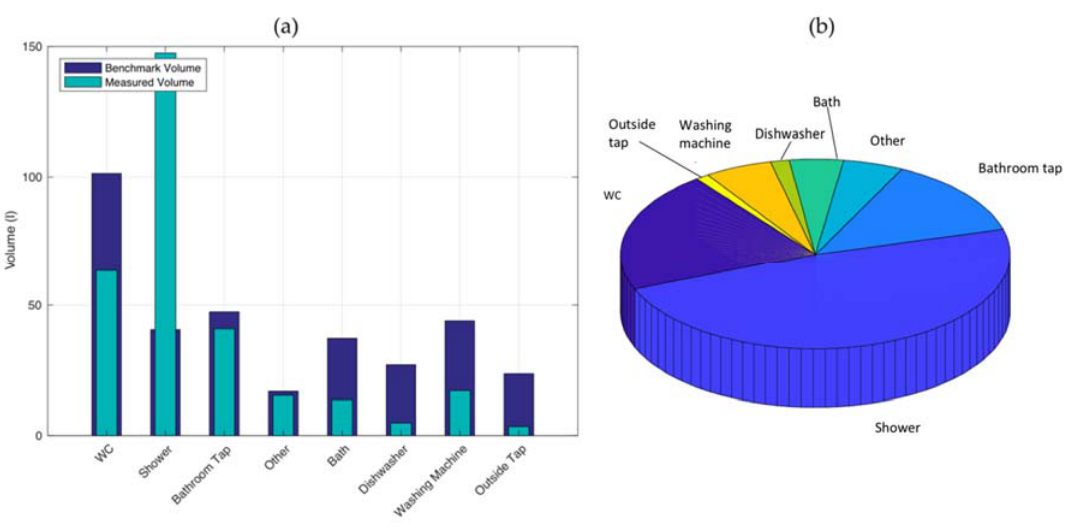
Figure 3. Performance Water Indicators (Number of users N = 2). Section ( a ): comparison between measured volume (green bars) and reference volume (blue bars) linked to each end ‐ use type. Section ( b ): the repartition of global measured volume.